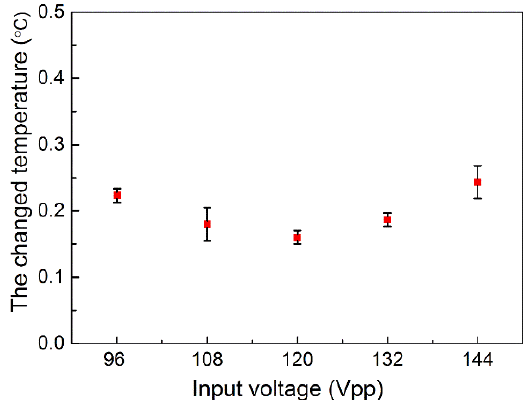
Figure 6. The surface temperature of the PDMS for different input electronic powers. There is no significant difference for input voltages of 96, 108, 120,132, and 144 Vpp. The temperature elevation is as small as 0.3 °C.